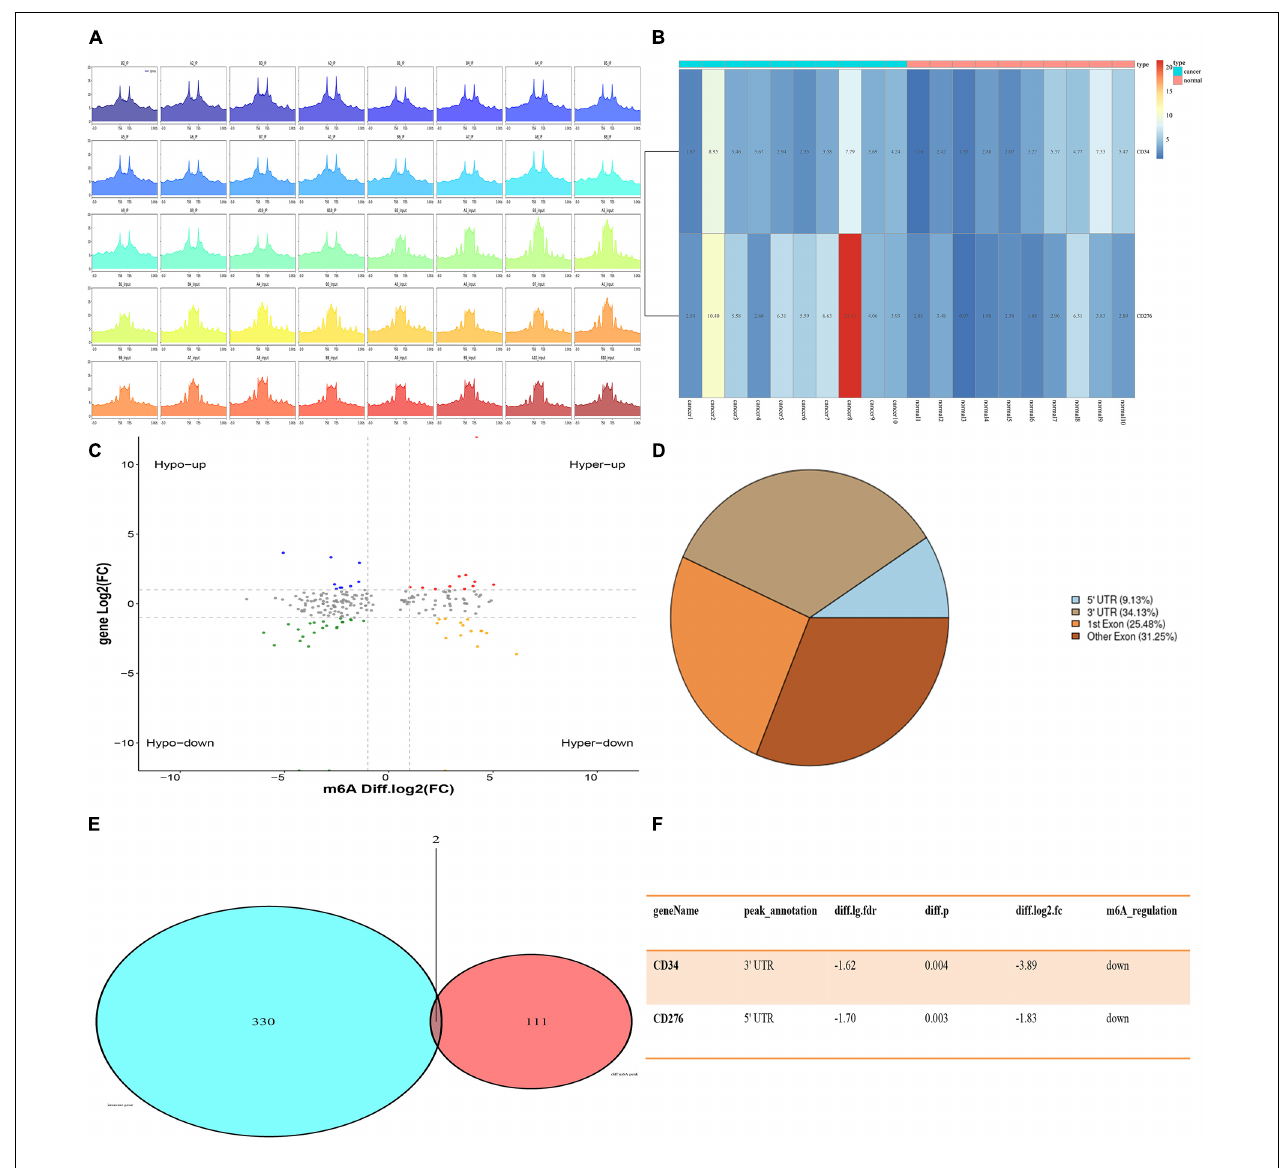
FIGURE 1 | Expression of CD34/CD276 and m6A modification in CRC. (A) Peak statistics of clinical sequencing samples. (B) Compared with paracancerous tissues, the expression of CD276 was up-regulated in CRC tissue ( P < 0.05), while the expression of CD34 did not significantly change ( P > 0.05). (C) Difference m6A peak Volcano map. (D) Difference m6A peak calling. (E,F) CD34/CD276 is down-regulated m6A peak immune genes in CRC.